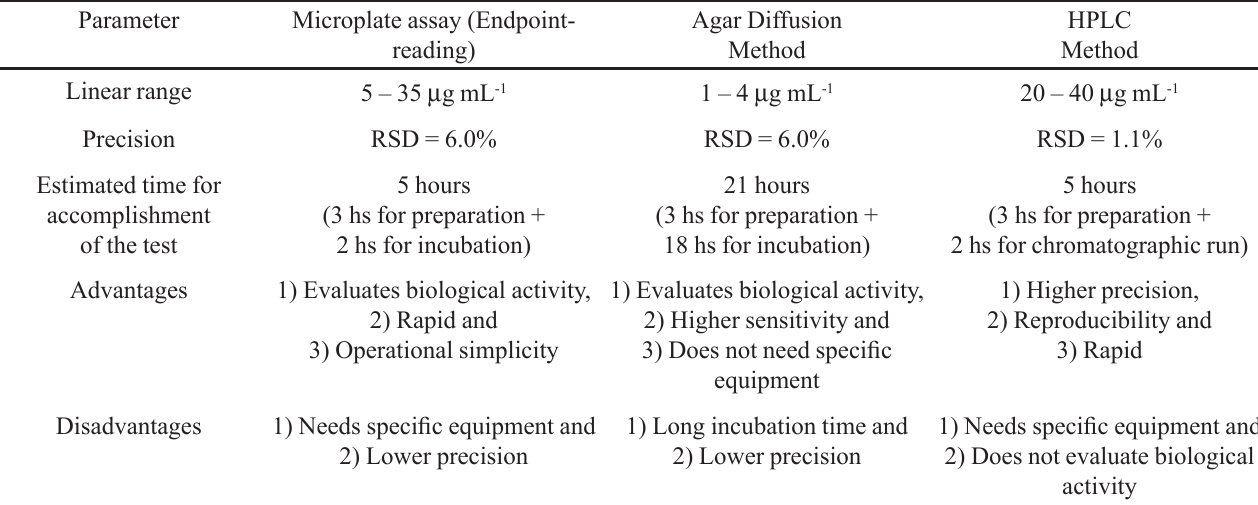
TABLE II - Comparison among microplate assay using endpoint-reading mode, the agar diffusion method and HPLC method employing OPA-mercaptoacetic acid